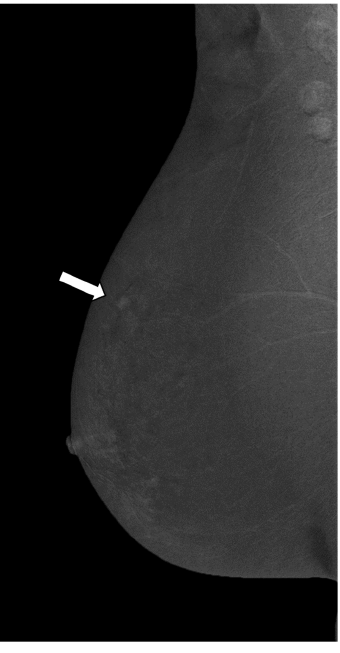
Figure 1. Mediolateral oblique (MLO) view of CESM subtraction images in a 61-year-old woman with mastodynia and dubious ultrasound finding of the right breast (BI RADS 4a). The subtraction image shows a mass enhancement in the upper outer quadrant of right breast (white arrow), measuring less than 10 mm. The enhancement is mild, homogeneous, regular, and purified (enhancement score 0). The biopsy confirms a benign lesion (fibrocystic mastopathy).